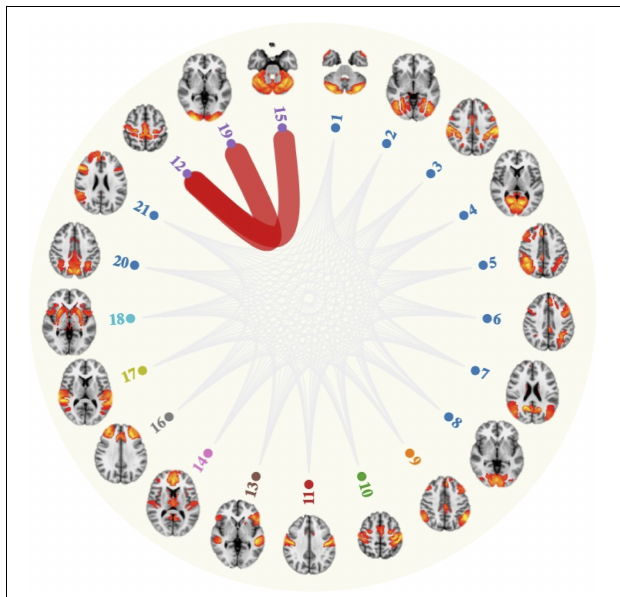
FIGURE 1 | Attending a sports club and gym on a weekly basis associated with stronger connectivity (red lines) between the sensorimotor network (node 12) and lateral visual network (node 19) and cerebellar network (node